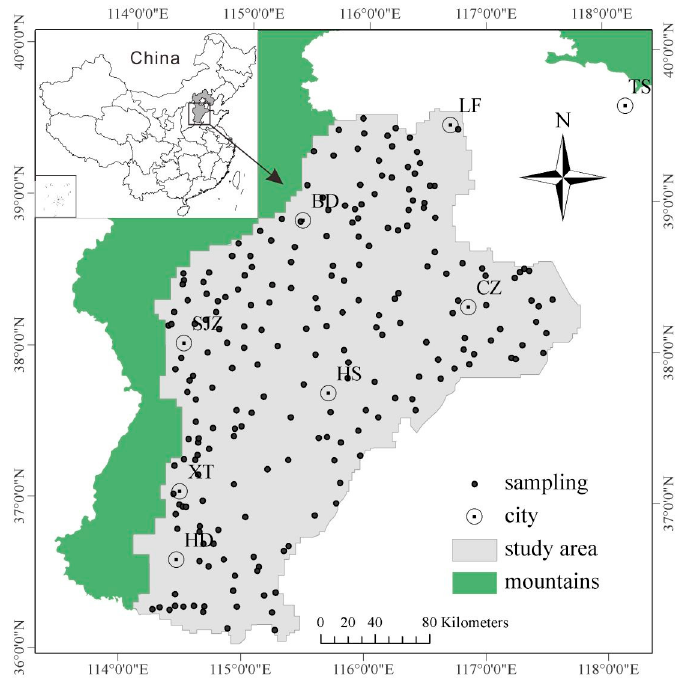
Figure 1. The sampling site map of soils and crops in the study area. (The city names Langfang, Baoding, Shijiazhuang, Cangzhou, Hengshui, Xingtai, and Handan have the abbreviations LF, BD, SJZ, CZ, HS, XT, and HD.) .